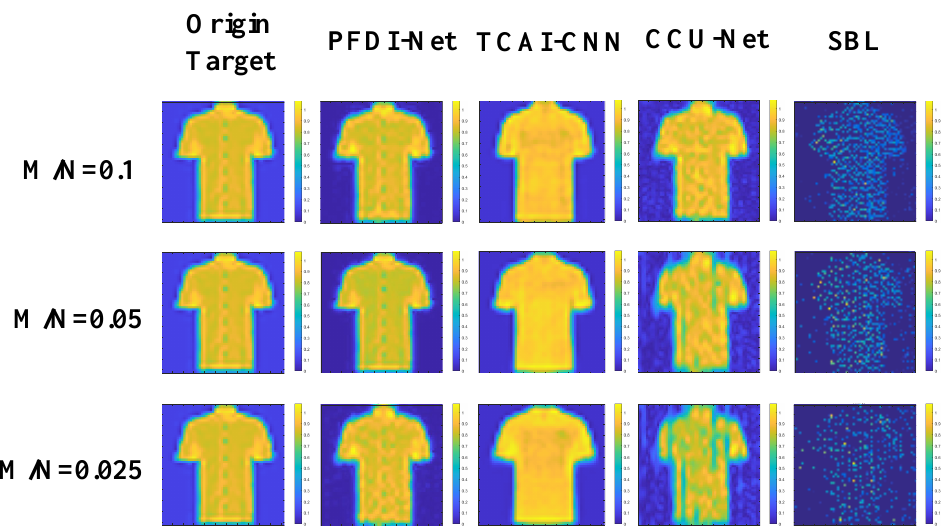
Figure 6. PFDI-FMNIST: Reconstruction results in four imaging algorithm with different scene information sampling